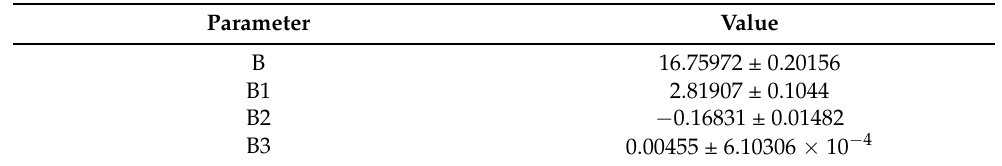
Figure 16. The relation between the collisions’ energy and the average charged particles when | η | < 2.4 and p > 0.1 GeV. T √ s and < n ch in the energy range between 2.36 TeV up to Table 2. Fitting parameters for the relation 14 TeV in the pseudorapidity region | η | < 2.4 and p T > 0.1